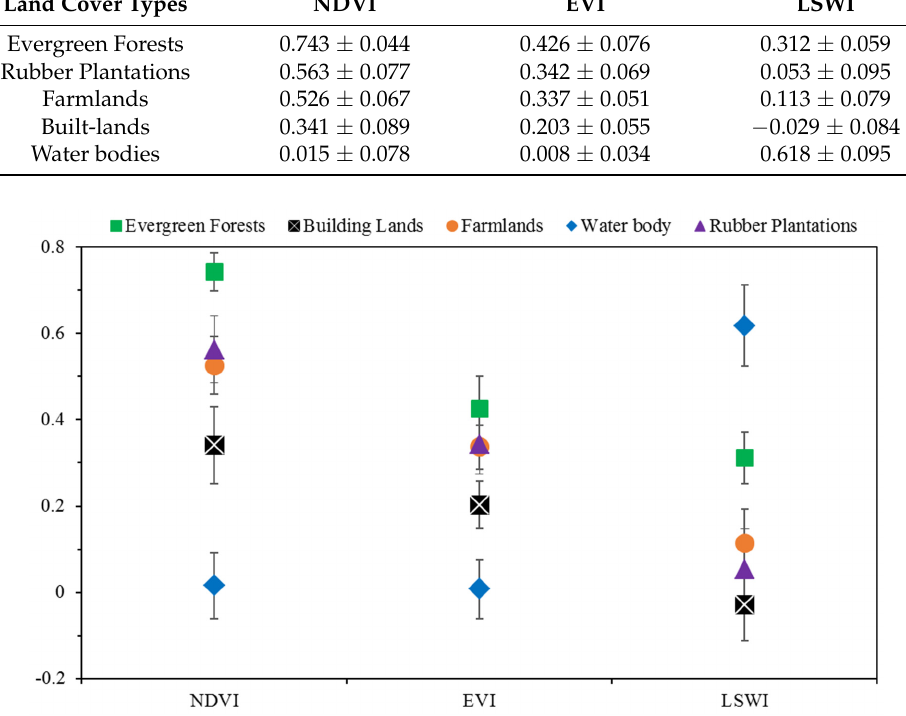
Table 2. NDVI, EVI, and LSWI of different land cover types of the study area of Xishuangbanna, Yunnan, China based on Landsat 5 TM images in 2010.